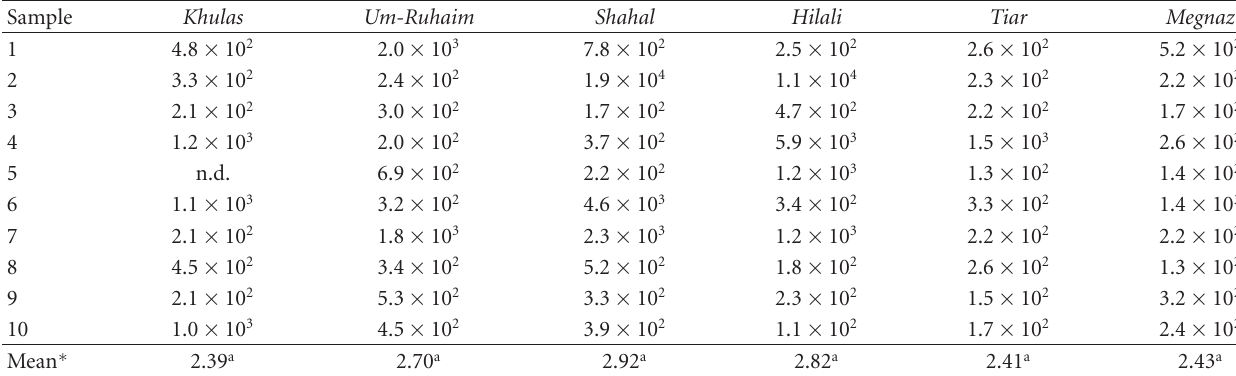
Table 2: Counts of yeasts and molds contaminating rutab samples (cfu/cm 2 ). Sample